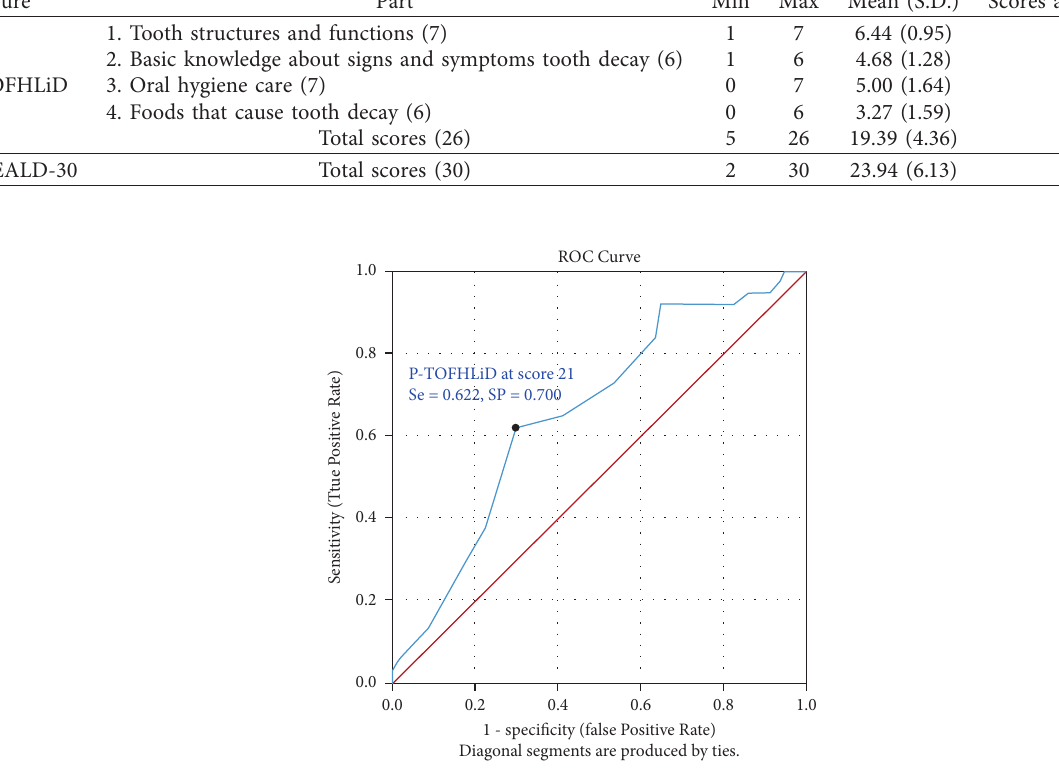
Figure 1: Receiving operation characteristic (ROC) curve of P-TOFHLiD scores to predict good oral health behaviour for considering appropriate cut-off scores.